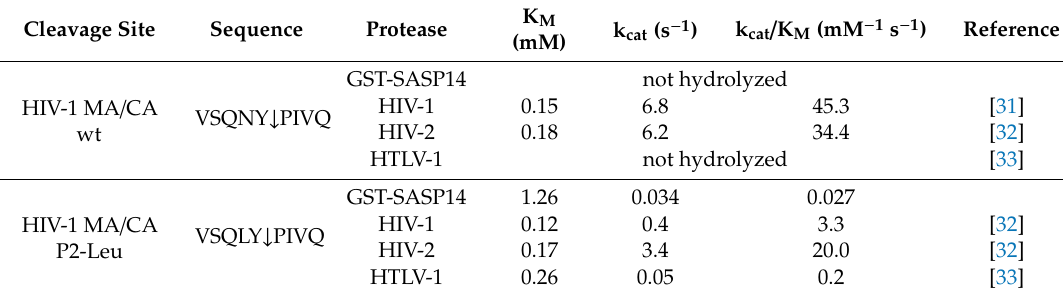
Figure 3. Purification of GST-SASP14 by a ffi nity chromatography. A representative gel shows the SDS-PAGE analysis of soluble lysate (SL), flow-through (FT), and eluate fractions from the a ffi nity-purification of wild-type GST-SASP14. Black arrow indicates GST-SASP14 and GST is shown by black arrowhead. Table 1. Catalytic e ffi ciency of GST-SASP14. Arrows indicate cleavage position in cleavage site sequences. References are indicated for those values that have been published